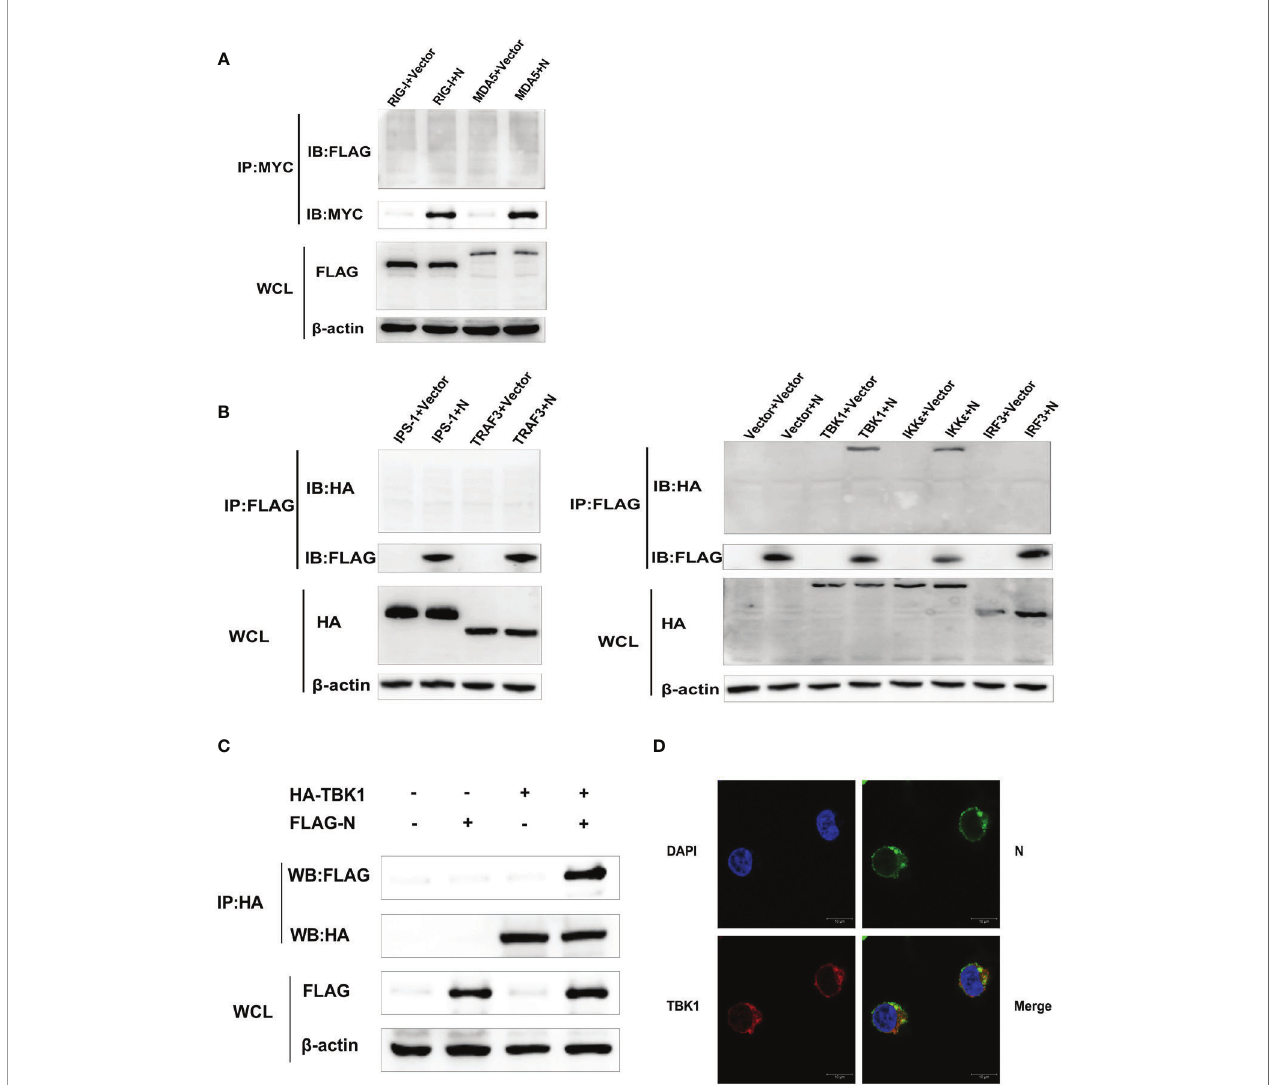
FIGURE 4 | SADS-CoV N protein interacts with TBK1. (A) HEK-293T cells were transfected with pcDNA-MYC-N along with Flag-RIG-I or Flag-MDA5. Then protein expression levels were analyzed by Western blot. (B) Or HEK-293T cells were transfected with pCMV-FLAG-N and a series of expression plasmids encoding the molecules of the RLRs ’ signaling pathway (HA-IPS-1, HA-TRAF3, HA-IKK ϵ , HA-TBK1, and HA-IRF3). The whole-cell lysates were collected and immunoprecipitated with the anti-Flag af fi nity gel or anti-MYC beads at 28 h post-transfection. Then protein expression levels were analyzed by Western blot. (C) HEK-293T cells were co-transfected with plasmids HA-TBK1 and plasmids pCMV-FLAG-N. After 28 h post cotransfection, the whole cell lysates and immunoprecipitated with the protein A/G magnetic beads containing anti-HA antibody. Then protein expression levels were analyzed by Western blot. (D) HEK-293T cells were co-transfected with plasmids HA-TBK1 and plasmids pCMV-FLAG-N. After 28 h cotransfection, IFA was used to analyze TBK1 protein and N protein ’ s subcellular localization in HEK- 293T cells by confocal laser scanning microscope (Leica SPE; Leica, Germany). Anti-HA antibody for detecting TBK1 (red), anti-FLAG antibody for detecting SADS- CoV N protein (green). The location of the nucleus was stained with DAPI